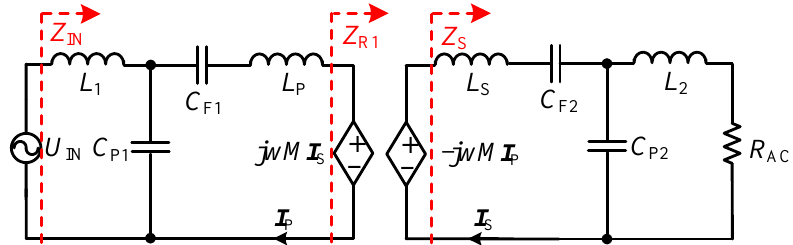
Figure 3. Equivalent M -type model of the DS-LCC topology for the CC charging. To facilitate the analysis, the equivalent M -type model in Figure 3 can be converted into the model shown in Figure 4.